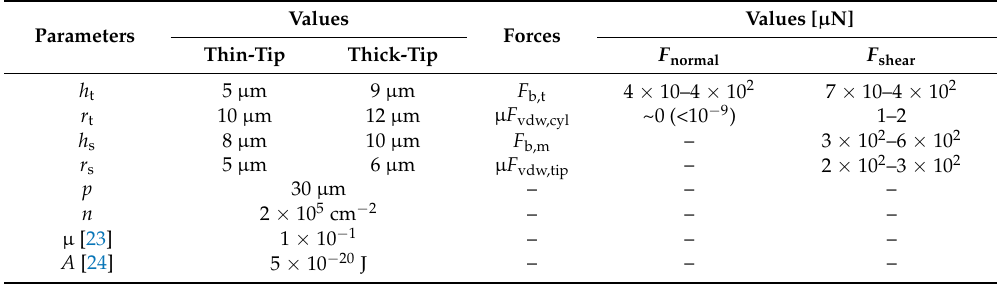
Table 2. Estimated values of each parameter and force used for the theoretical calculation of the interlocking